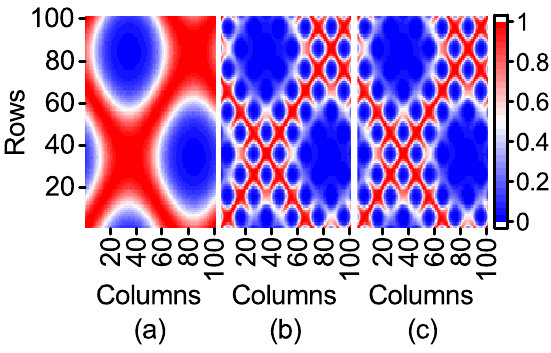
Figure 4. Three 2D heat-maps of kernel matrices: ( a ) feature weighting; ( b ) min-max normalization; ( c ) Z-normalization.